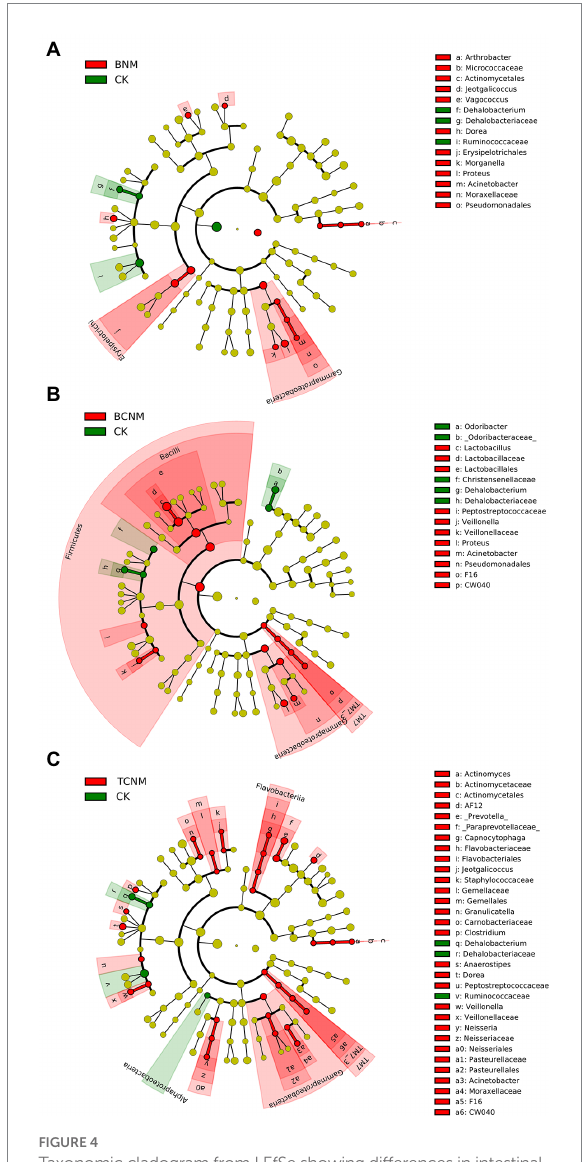
FIGURE 4 Taxonomic cladogram from LEfSe showing differences in intestinal flora by HNMs exposure. (A) BNM; (B) BCNM; (C) TCNM. Dot size is proportional to the abundance of the taxon. LDA